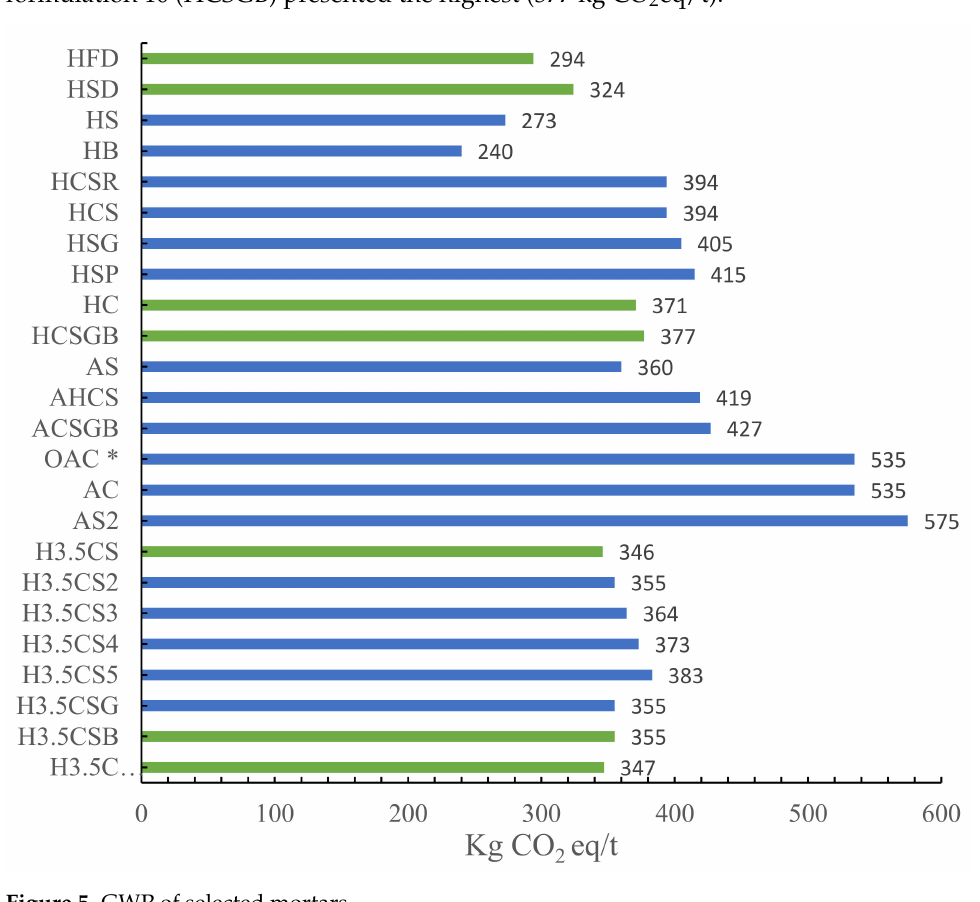
Figure 5. GWP of selected mortars.